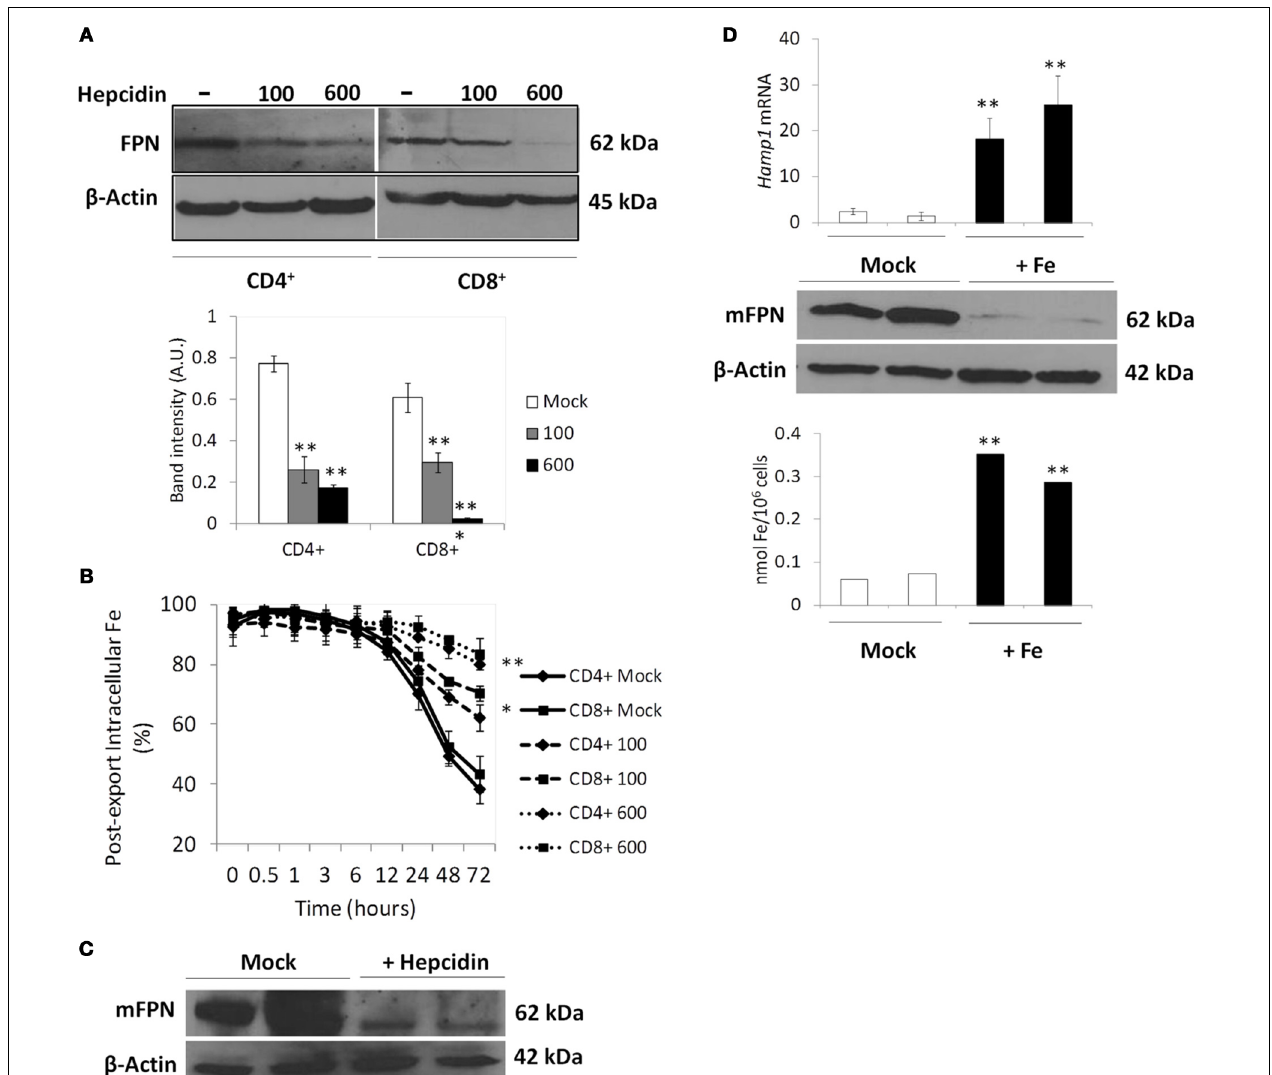
FIGURE 4 | Modulation of FPN1 expression and iron export by hepcidin in human and mouse T lymphocytes. (A) Modulation of Ferroportin (FPN1) by hepcidin in human T lymphocytes. Western blot quantification of FPN1 in CD4 + and CD8 + T lymphocytes incubated with the indicated concentrations (ng/ml) of hepcidin for 24h. β -actin expression was used as loading control. Images are representative of three experiments without significant inter-experimental variation. Bottom panel: Scanning densitometry of FPN1 Western blot. Data are normalized for β -actin levels and are expressed as arbitrary units (AU). ∗∗ P < 0 . 005 (One-Way ANOVA) between relative FPN1 levels in Mock- and hepcidin-supplemented conditions. (B) Modulation of iron retention by hepcidin. Each point represents the mean value ± 1 SD ( n = 3) of intracellular iron in human T lymphocytes incubated with 5 μ M of 55 Fe-citrate for 2h and allowed to export iron in an NTBI-free medium, in the presence (100 or 600ng/ml) or absence (Mock) of hepcidin, for up to 72h. ∗ P < 0 . 05